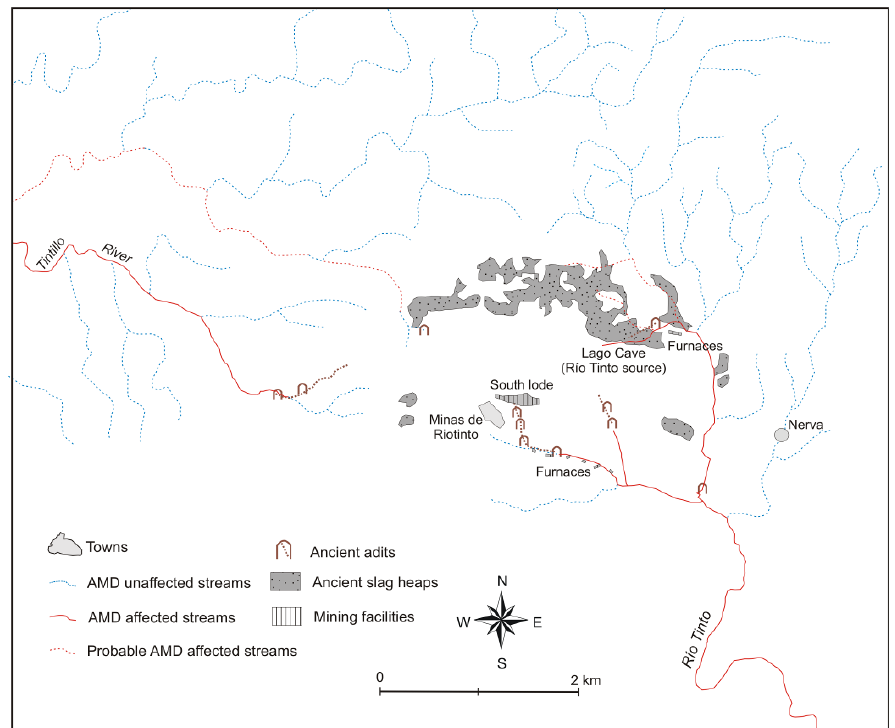
Figure 6. Reconstruction of the impact of mining in the Río Tinto headwaters before 1850. Location of mining wastes and facilities have been taken from [36,37]. The represented area corresponds to the inner square in Figure 1.